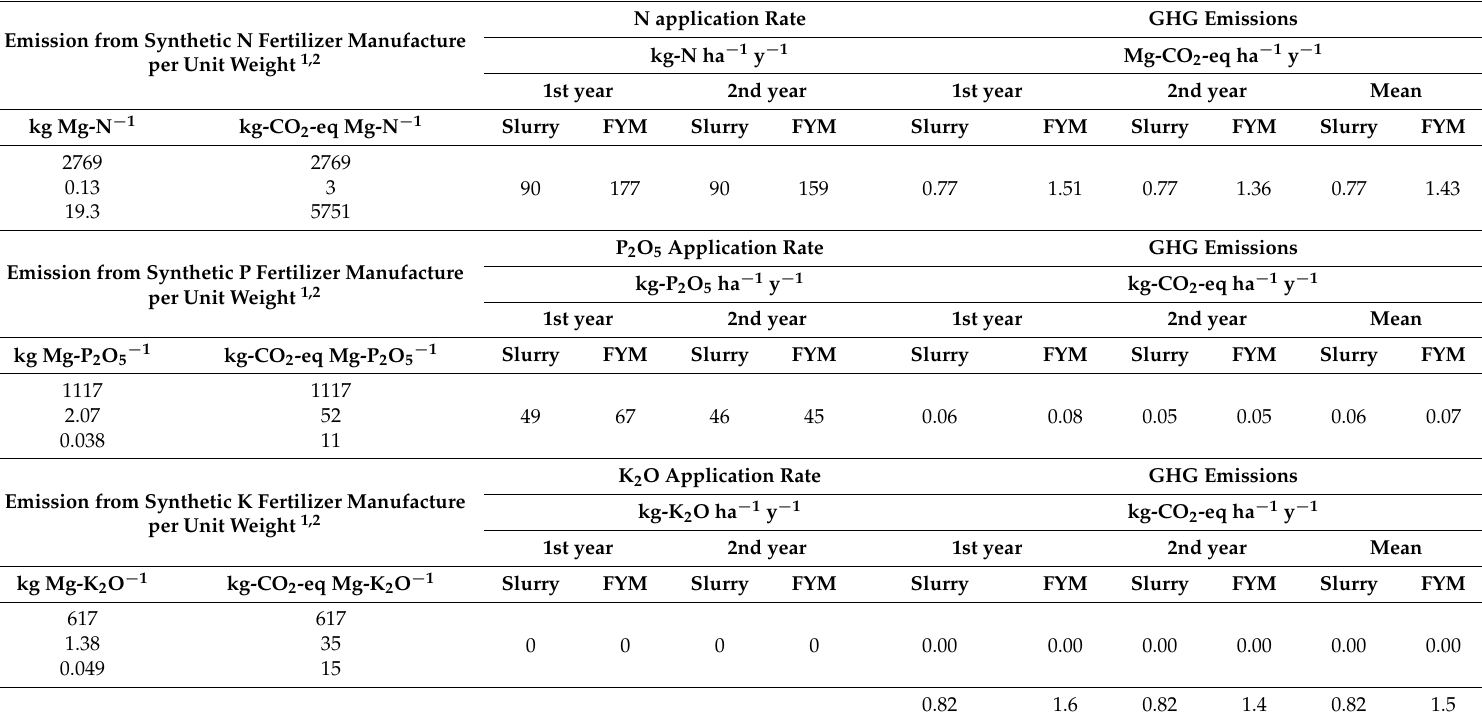
Table 6. Emissions of GHG related to synthetic fertilizer